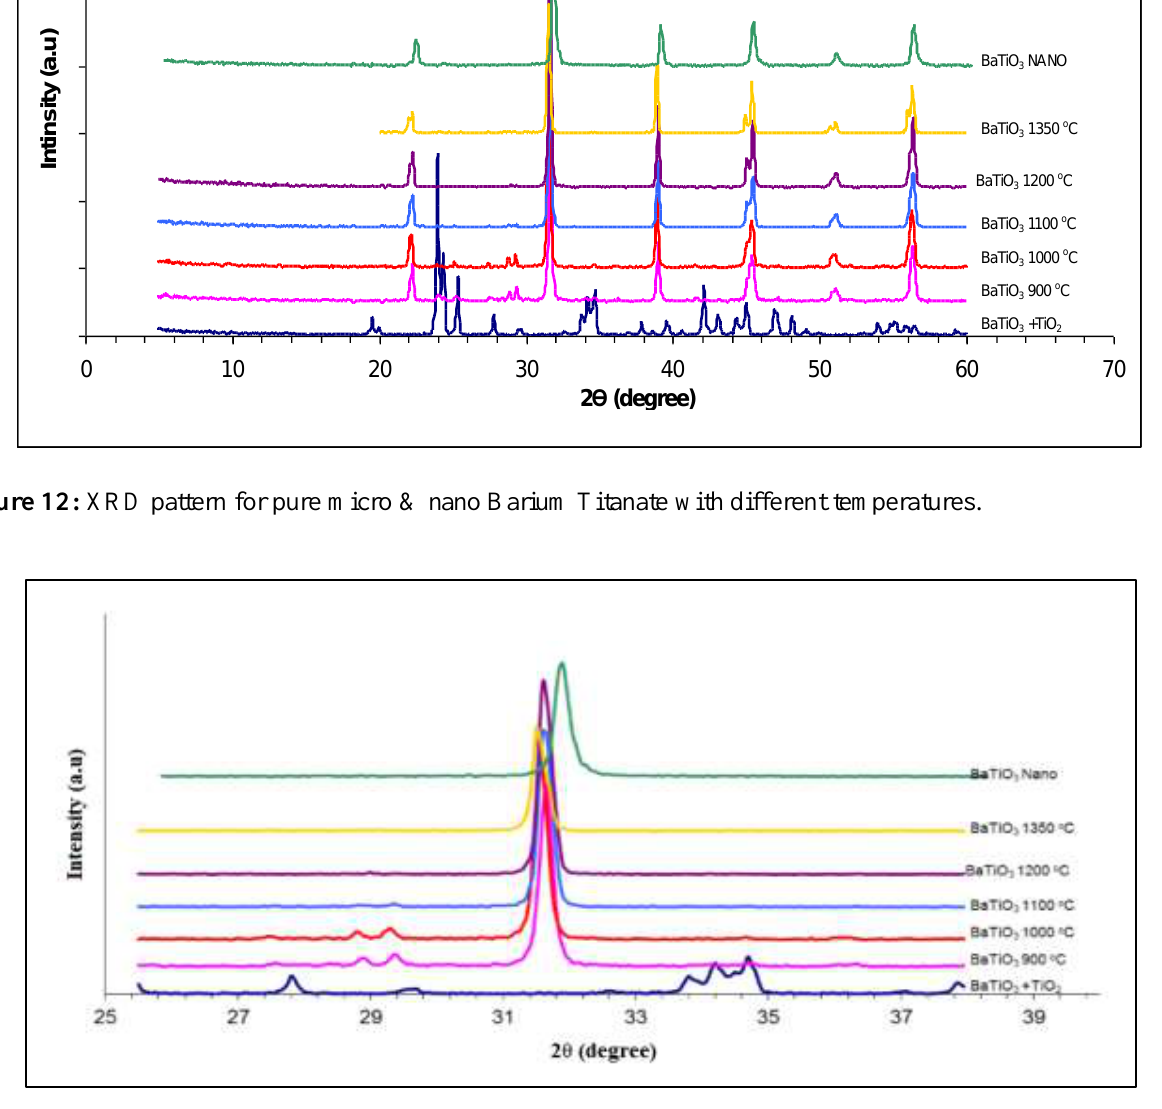
Figure 13: Illustrates shifting in the peaks of XRD patterns for pure micro and nano BaTiO 3